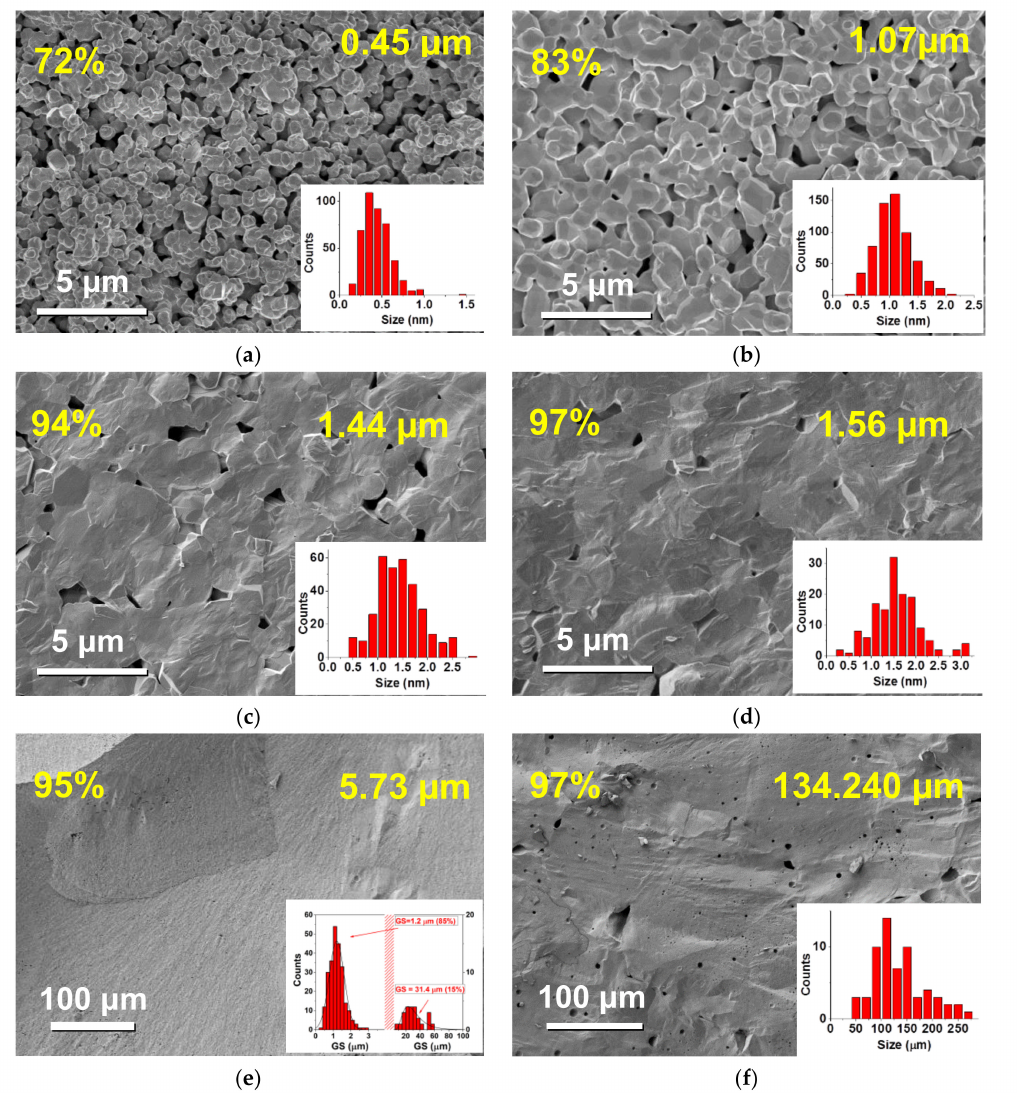
Figure 1. The e ff ect of processing conditions on microstructure: ( a – f ) micrographs and histograms of BaZr 0.05 Ti 0.95 O 3 (BZT)